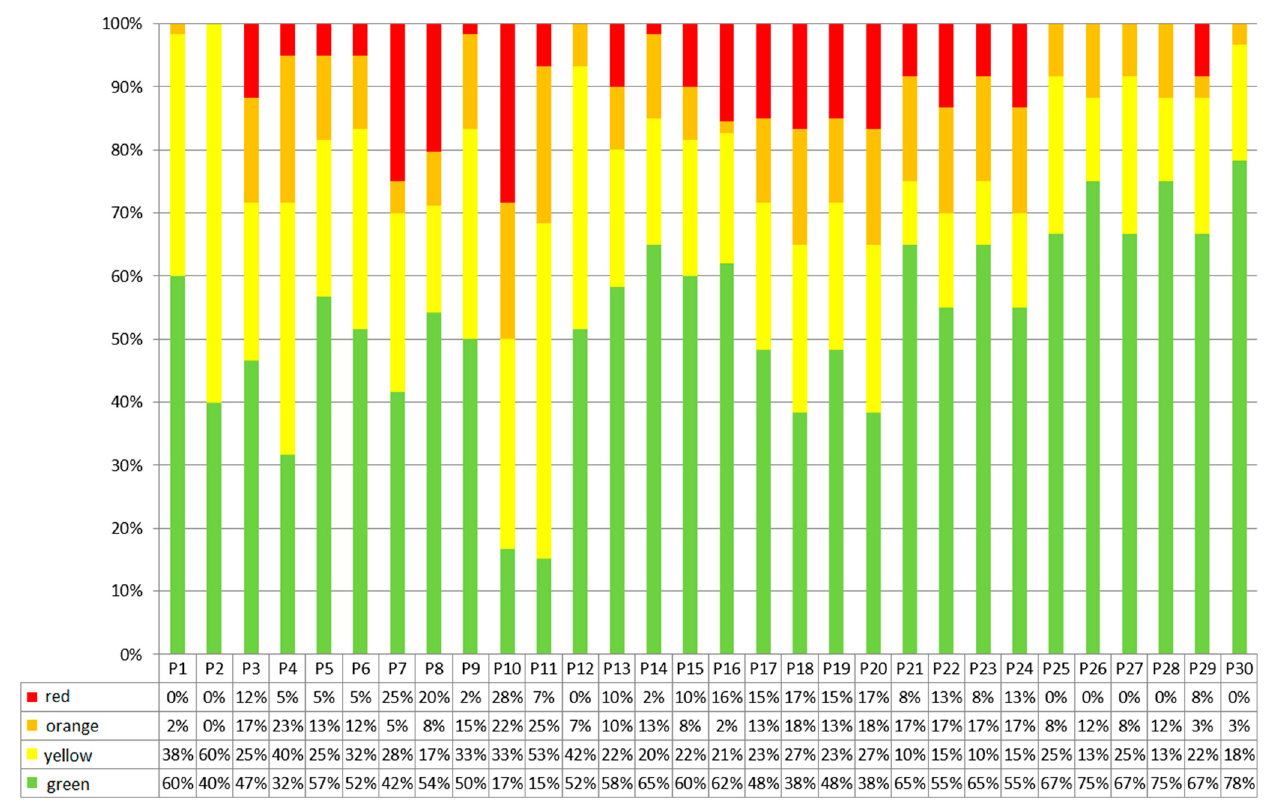
Figure 2. Percentage distribution of results in 4 defined ranges (green, yellow, orange and red) for 30 parameters obtained from patients after stroke—dominant upper limb.